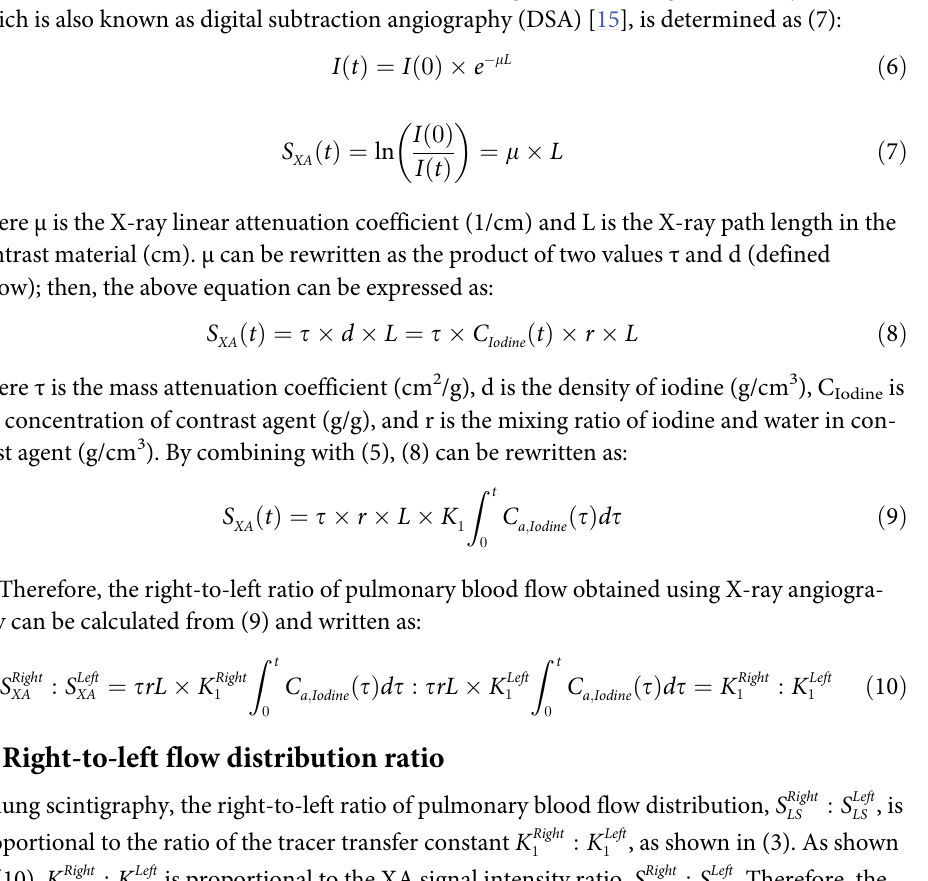
C. Right-to-left flow distribution